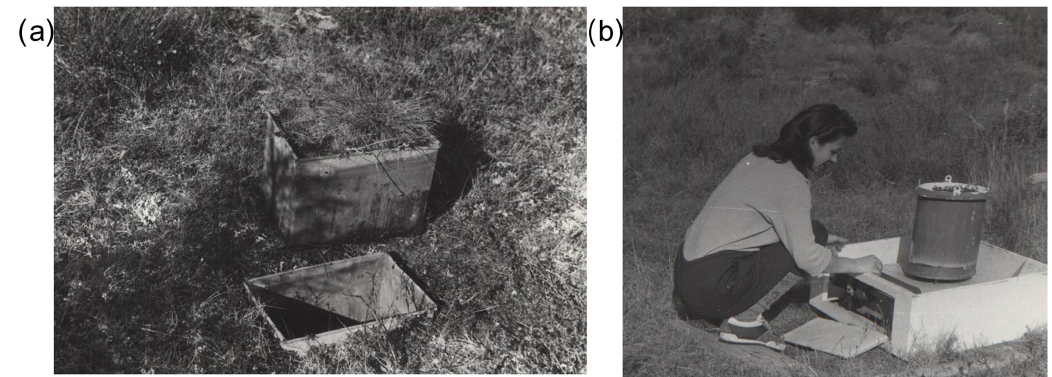
Figure 5. (a) Rykachev evaporimeter; (b) weighing the GGI-500-30 evaporimeter (Sushansky, 1989).